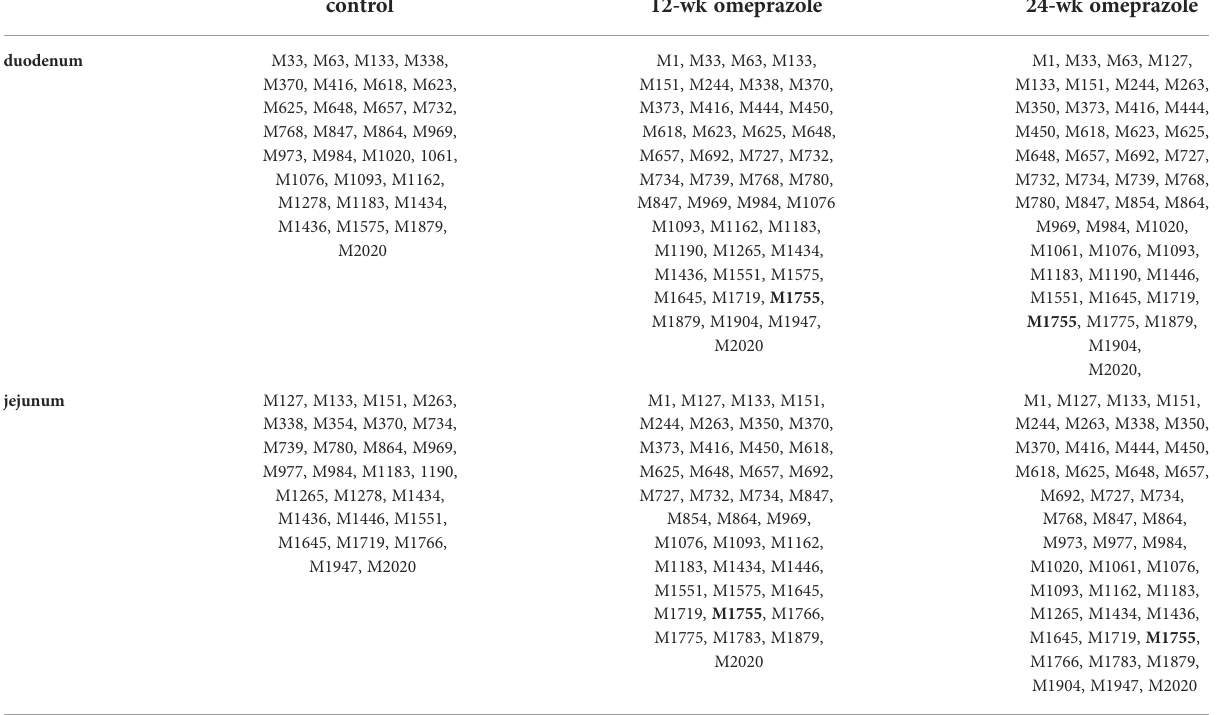
TABLE 3 Methionine oxidation in TRPM6 protein from duodenum and jejunum of control or omeprazole-treated rats.